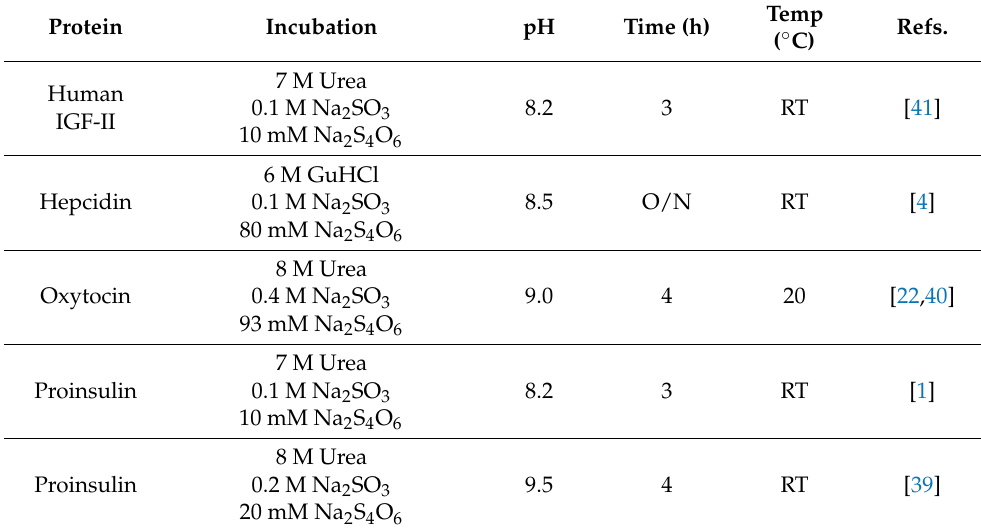
Table 1. Conditions for oxidative sulfitolysis of polypeptides. Protein Incubation pH Time (h) 7 M Urea Human 0.1 M Na 2 SO 3 RT [41] IGF-II 6 M GuHCl Hepcidin